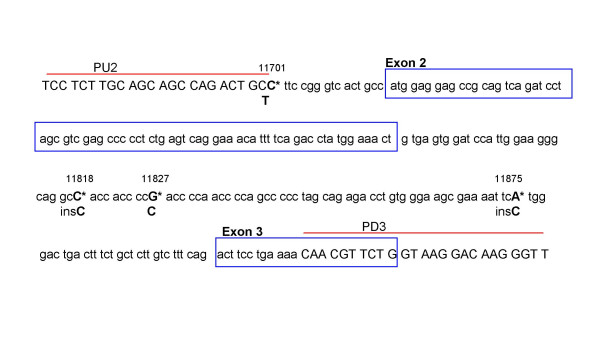
Single nucleotide polymorphisms detected in intron 1 and intron 2 sequences of the TP53 gene in melanoma tumors. Each polymorphism and its positions are indicated by an asterisk (*), to determinate the presence of the polymorphisms the DNA sequence from melanoma tumors and autologous PBLs were compared with control PBLs.